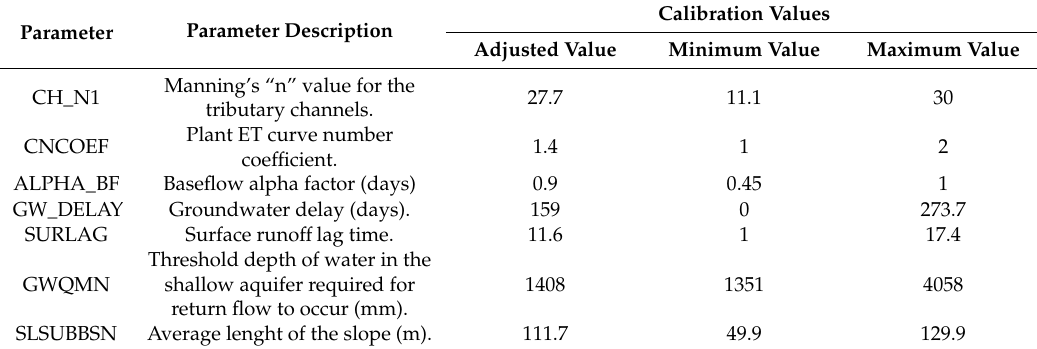
Table 4. Sensitive parameters in surface flow calculations, calibrated